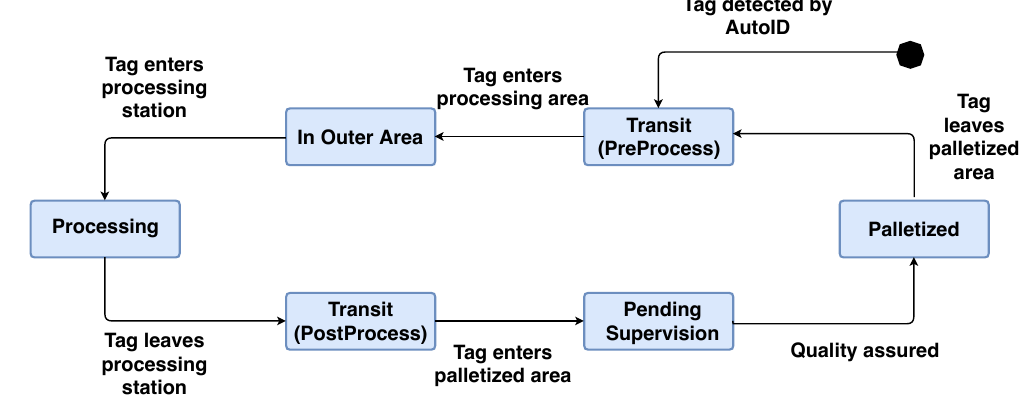
Figure 9. Pipe life-cycle state